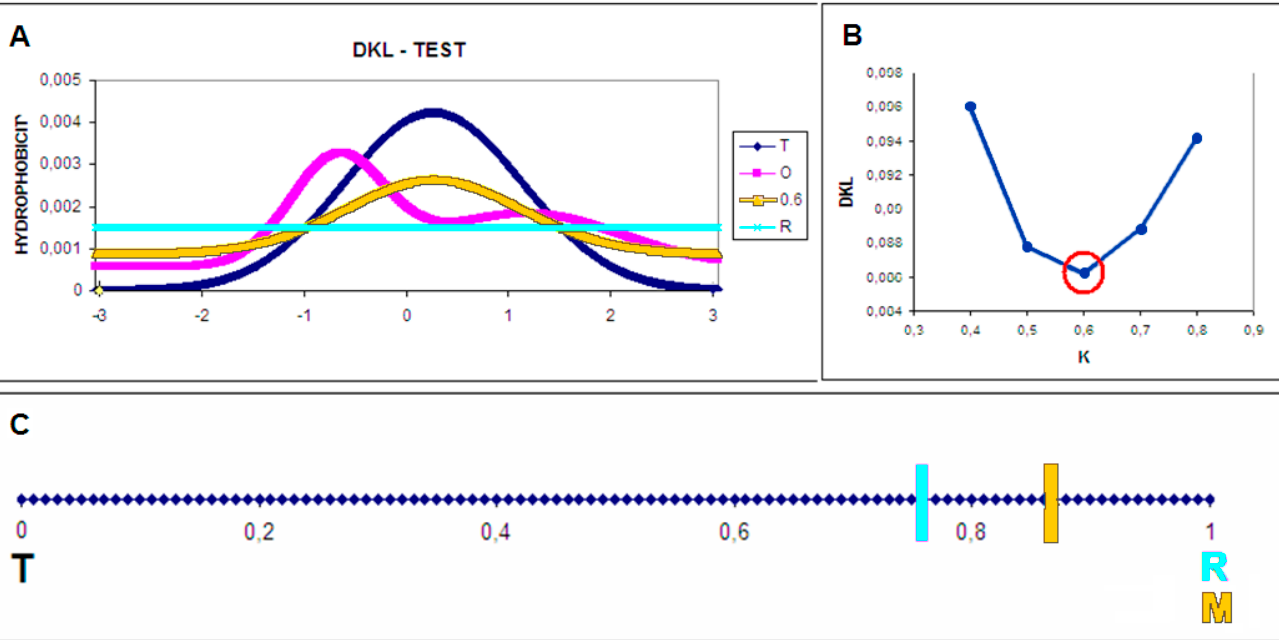
Figure 1. The O distribution in relation to the T , M and R distributions (randomly constructed distributions for the 1-dimensional Gauss distribution); ( A ) T distribution (navy), O (pink), R (turquoise), and M (yellow); and ( B ) D KL values for different values of K —the optimal K values for the discussed example are marked with red. The RD values for the T–O–R and T–O–M relationships are equal to 0.760 and 0.873, respectively. ( C ) The scale of the RD values for the reference distributions versus the O distribution. The determined values of RD (as given in B) located on the variation axis of the RD parameter show significant compatibility with the M distribution compared to the reference distribution R .